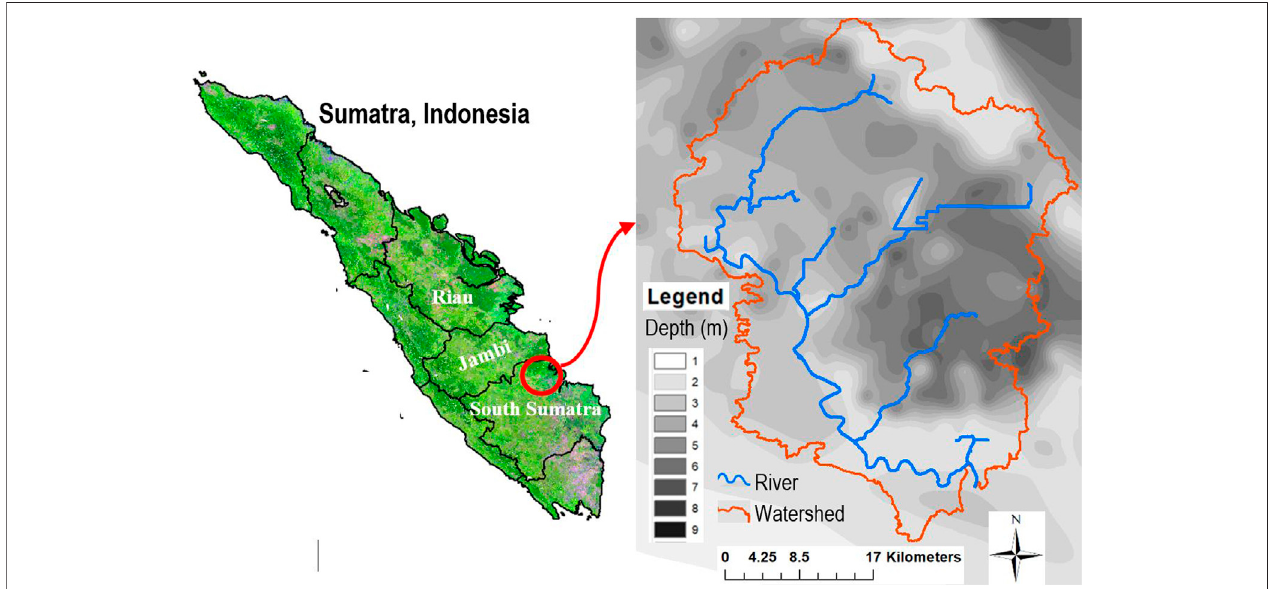
FIGURE 1 | Study site in South Sumatra Province, Indonesia with a peat-depth map.